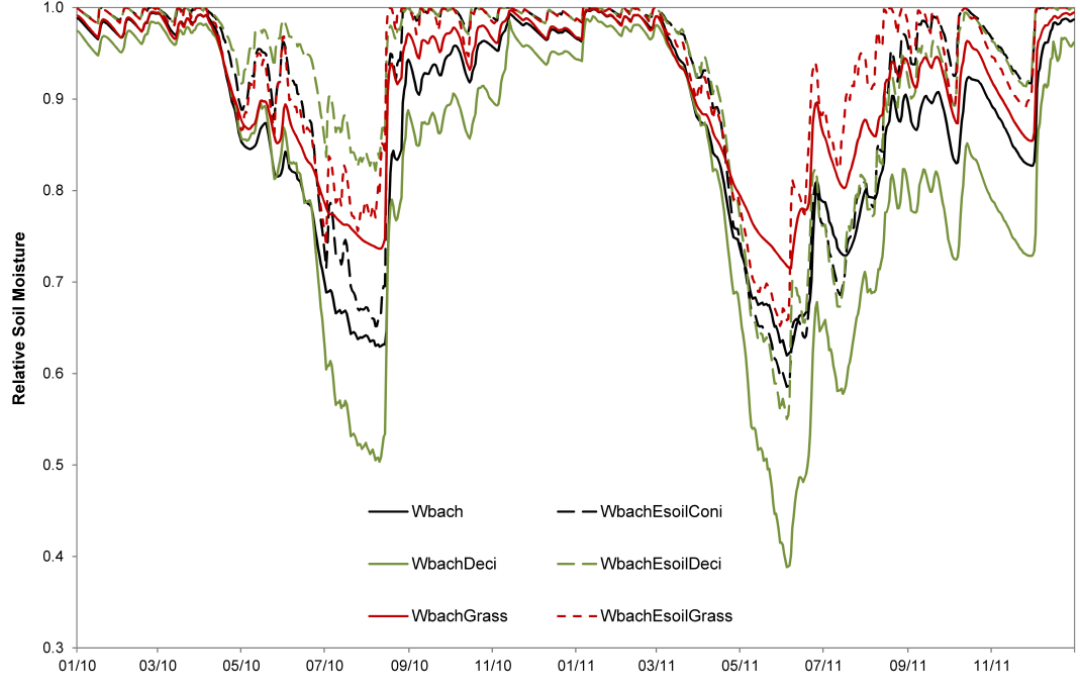
Figure 4. Soil moisture dynamics of the Wüstebach simulations at 20 cm depth.